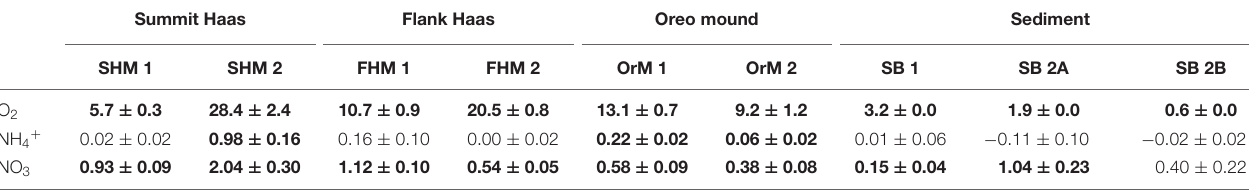
TABLE 4 | Benthic O 2 and DIN fluxes measured from the BC incubation experiments expressed in mmol m − 2 d − 1 . Summit Haas Flank Haas Oreo mound